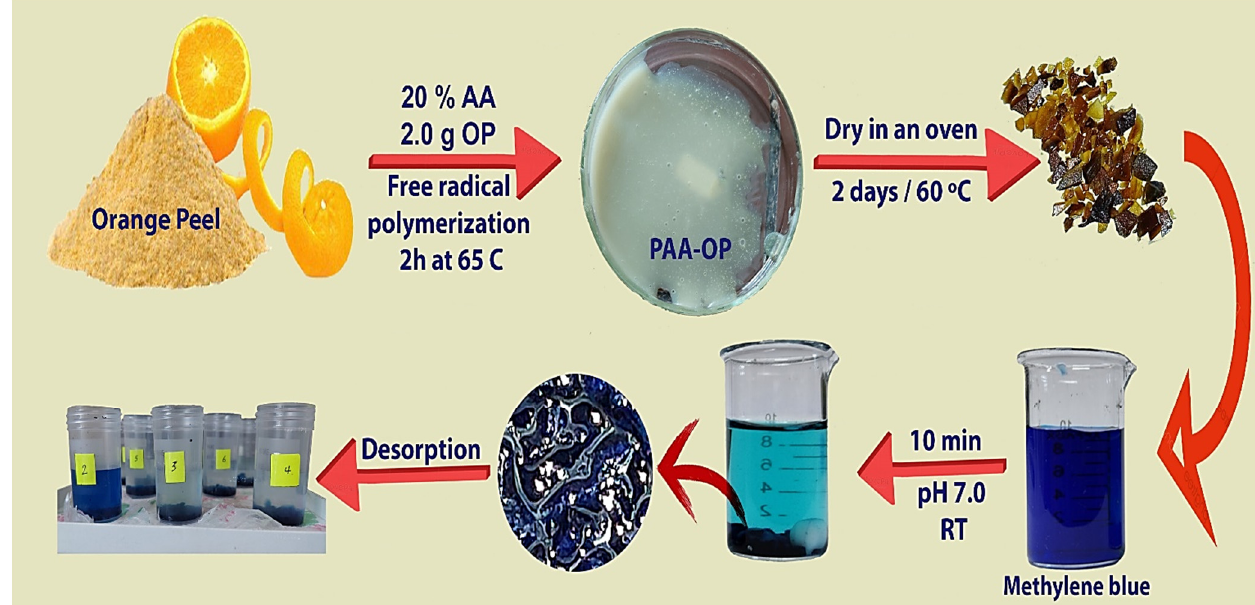
Figure 13. Adsorption and Desorption of MB from Polymer E at different pH (2–9). Experimental conditions were: adsorbents hydrogel dose: 2.0 g in 25 mL for 1 h at RT.